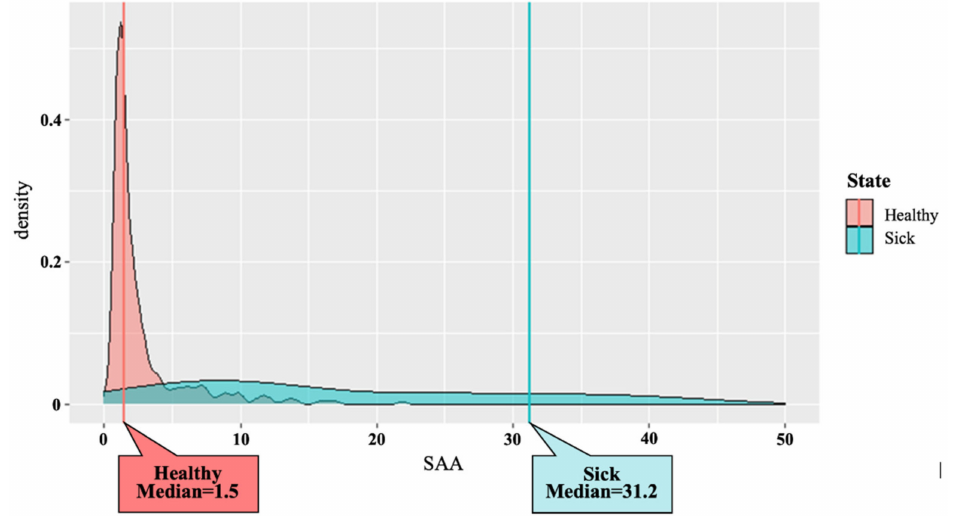
Figure 1. Distribution pattern of the serum amyloid A concentrations derived from cows in both healthy ( n = 289) and diseased groups ( n =